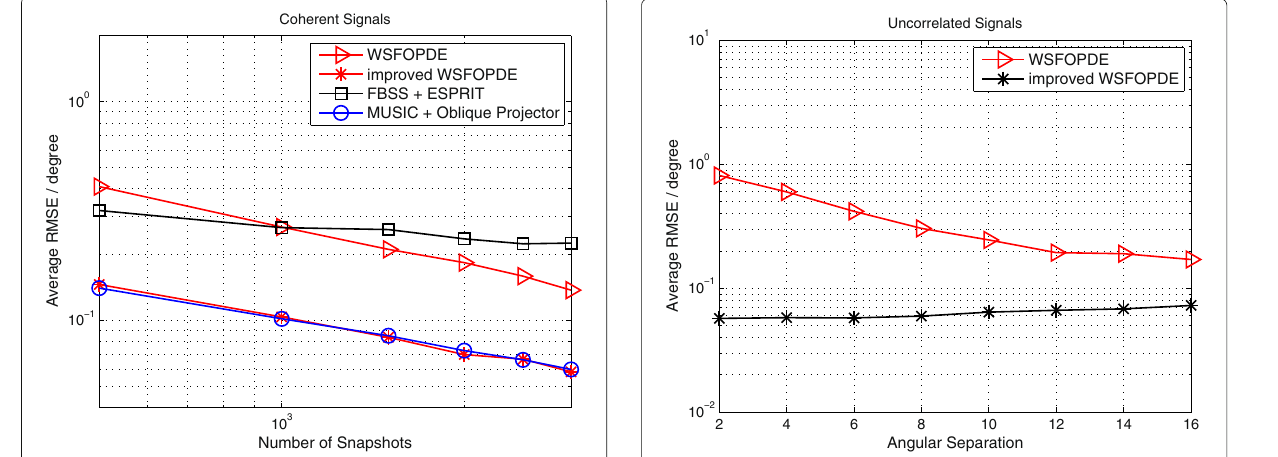
Fig. 4 The DOA-DOD estimation performance versus the number of snapshots: coherent signals